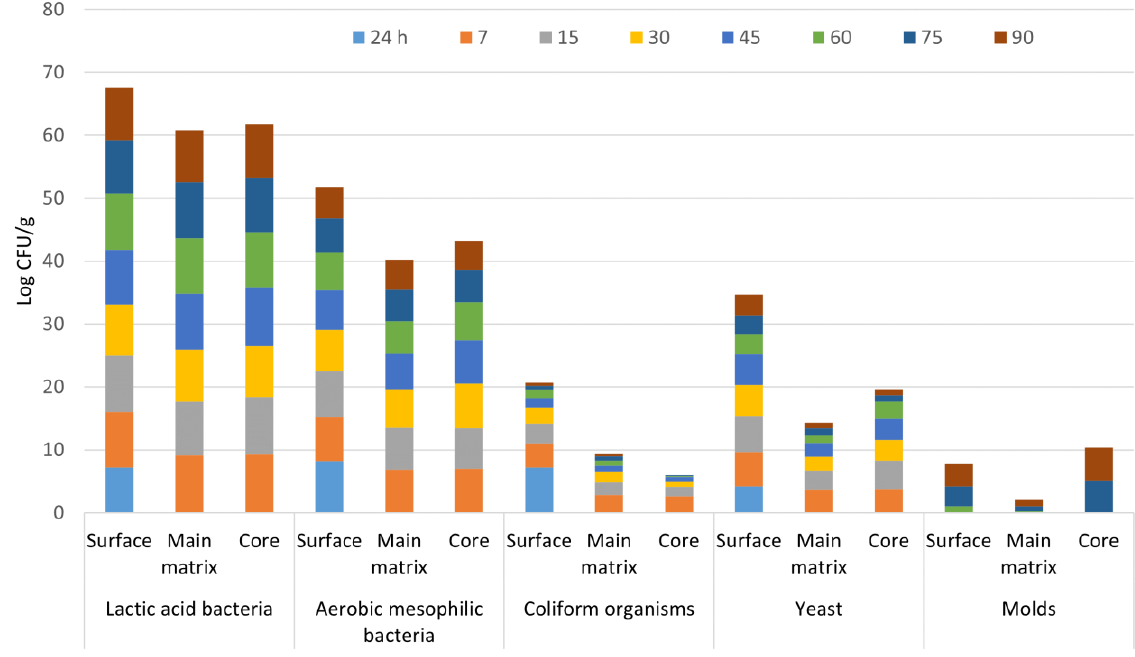
Figure 2. Behavior of indicator groups in Cotija cheese during its maturation process.